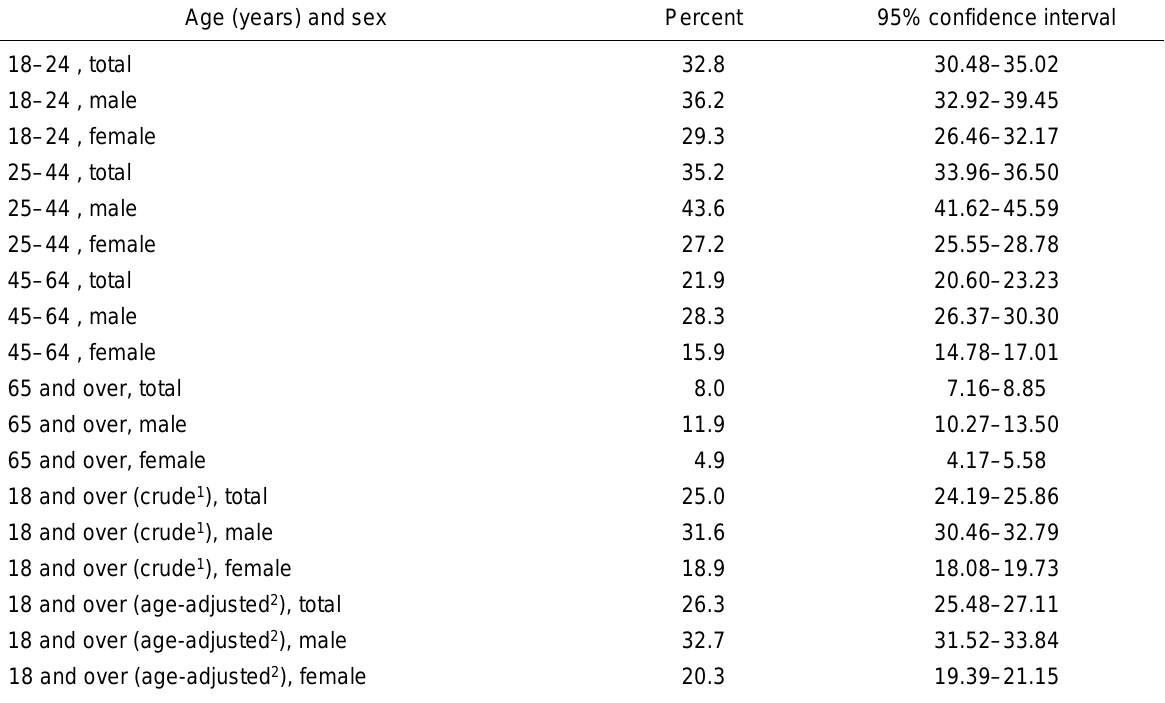
Data table for Figure 9.2. Percentage of adults aged 18 and over who had at